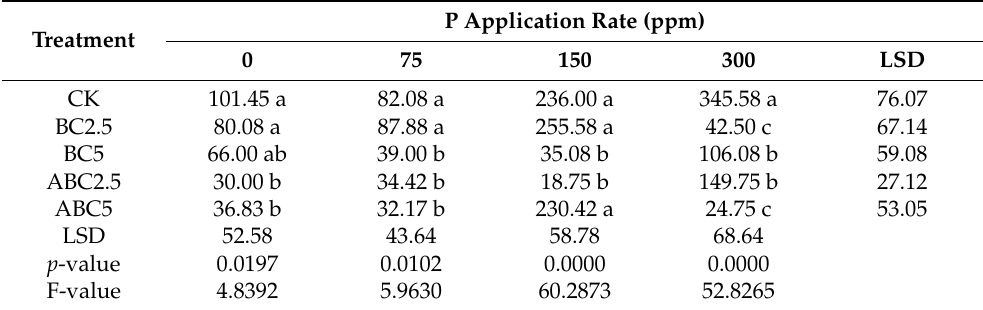
Table 13. Effects of BC and ABC applied at different rates with different P fertilizer application rates on Plant Zn concentration